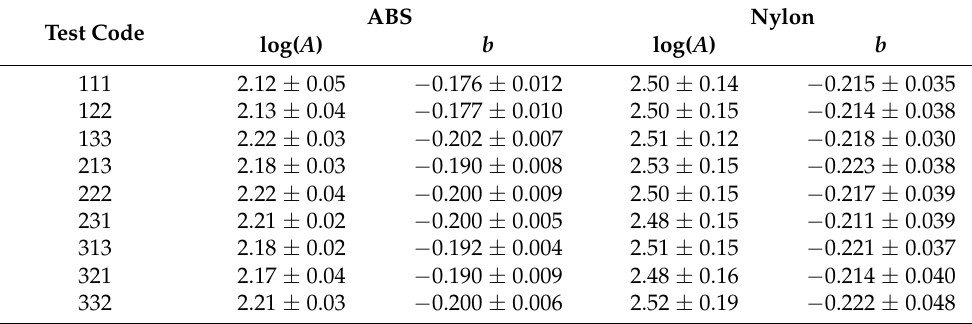
Table 5. Basquin’s parameters.